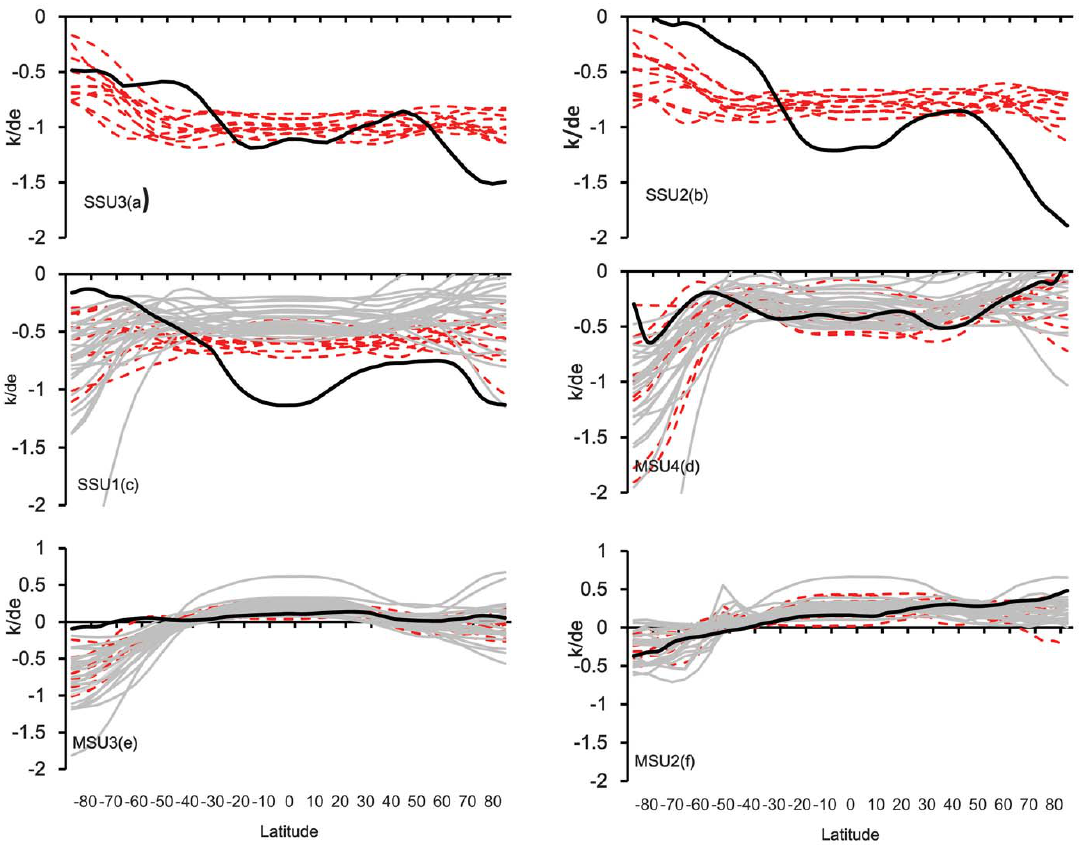
Figure 5. Temperature trend change with latitude for the layers ( a ) SSU3; ( b ) SSU2; ( c ) SSU1; ( d ) MSU4; ( e ) MSU3; ( f ) MSU2. Note SSU1~3 and MSU2~4 represent the SSU/MSU observational layers. Heavy black line indicates the SSU/MSU observation, gray and red thin lines represent the low-top and high top CMIP5 model,